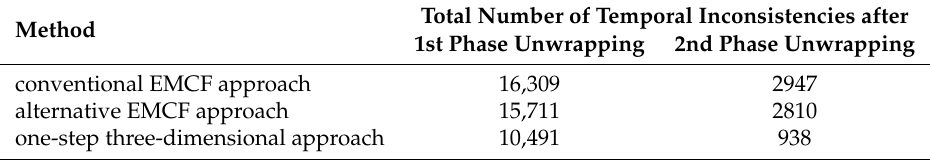
Table 2. Number of total temporal inconsistencies for ERS 1/2 data. The number is listed for